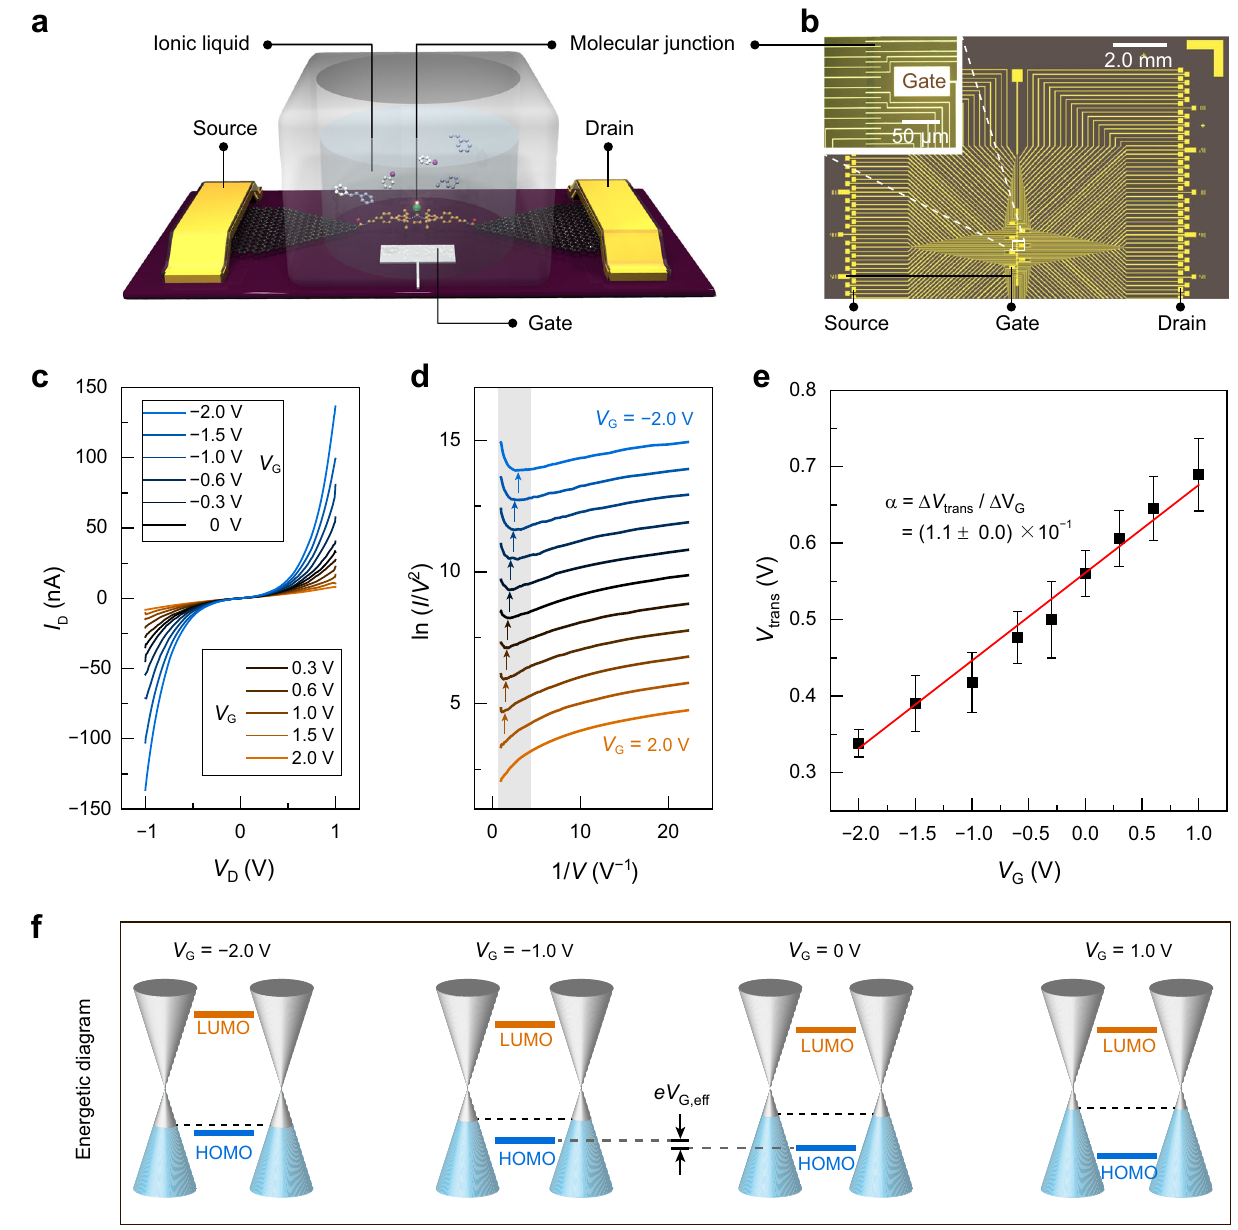
Fig. 4 | Molecular orbital gating in a single-molecule device. a Schematic of a single-moleculedevicewithanionicliquidgateelectrode(connectedwitharemote metal gate electrode) for the Mizoroki – Heck reaction. Ionic liquid: 1-butyl-3- methylimidazolium tetra fl uoroborate. b Photograph of a real device with metal gate electrodes. Inset: enlarged area of the device. c I – V curves measured for dif- ferent values of V G based on a Pd(0) GMG-SMJ. d Fowler – Nordheim plots corre- sponding to the I – V curves in c . The arrows indicate the boundaries between